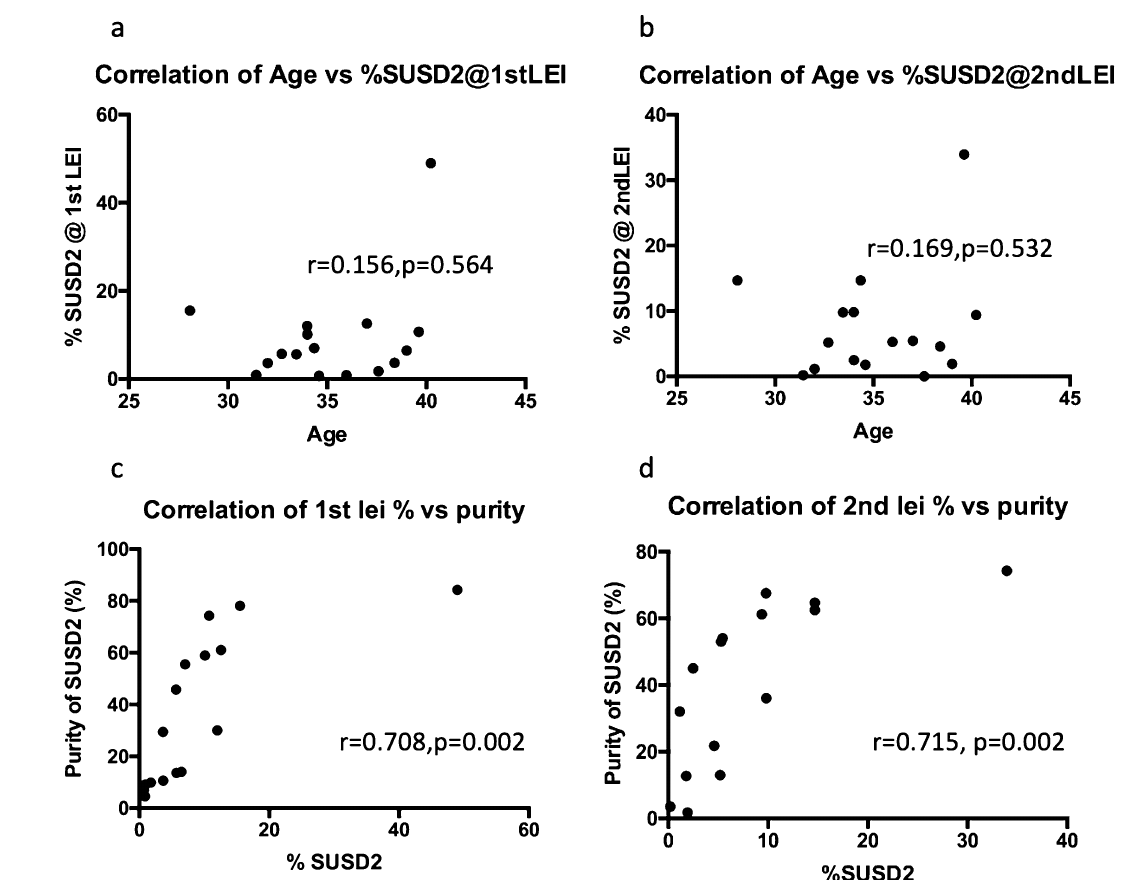
Figure 3. Correlation analysis of %SUSD2 + cells and subject age at ( a ) first and ( b ) second LEI and purity following magnetic cell sorting using SUSD2 magnetic beads for first ( c ) and second ( d ) LEI. (n = 26 for first LEI and n = 20 for second LEI).